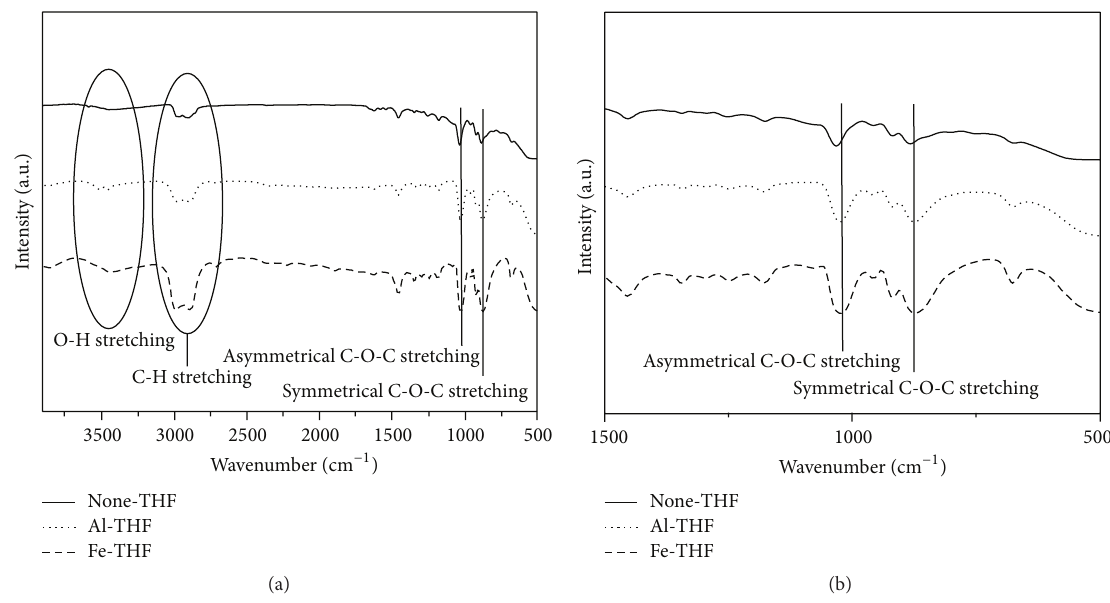
Figure 1: FT-IR spectra of catalysts: in the range of 500–3900 cm −1 (a), extend in the range of 500–1500 cm −1 (b).